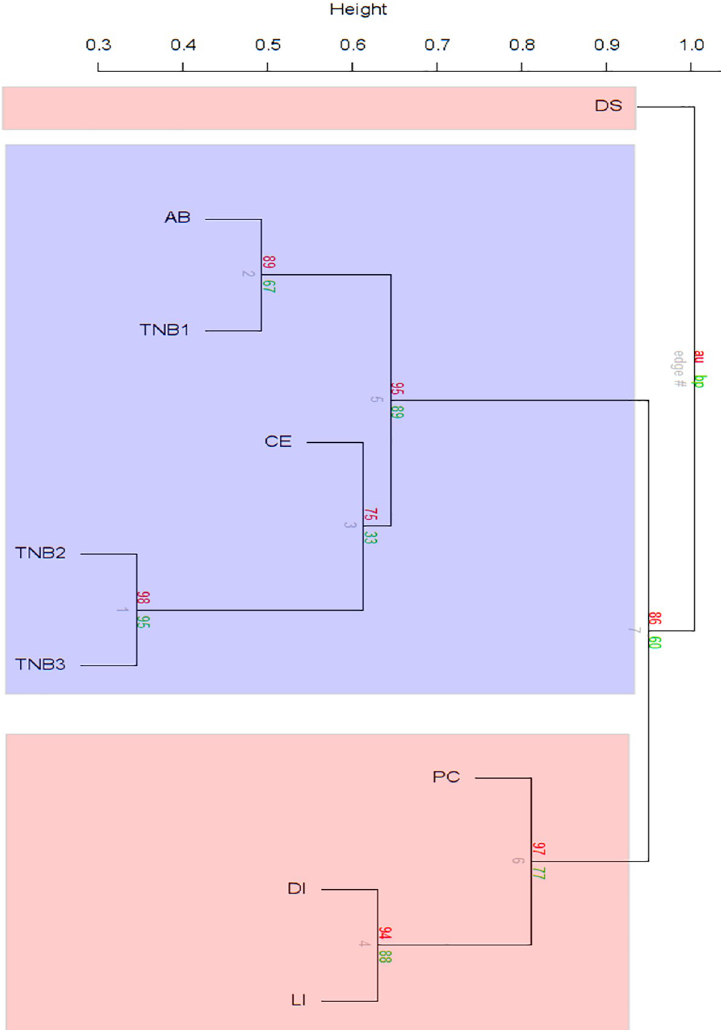
Fig 7. Hierarchical clustering calculated with 10,000 permutations with the studies of Davis Station (DS), Terra Nova Bay (TNB1, 2, 3), and South Shetland Islands (Deception [DI], Livingston [LI], and King George Island, divided into Potter Cove [PC] and Admiralty Bay [AB]) with presence-absence data aggregated at the study level (n total = 192).